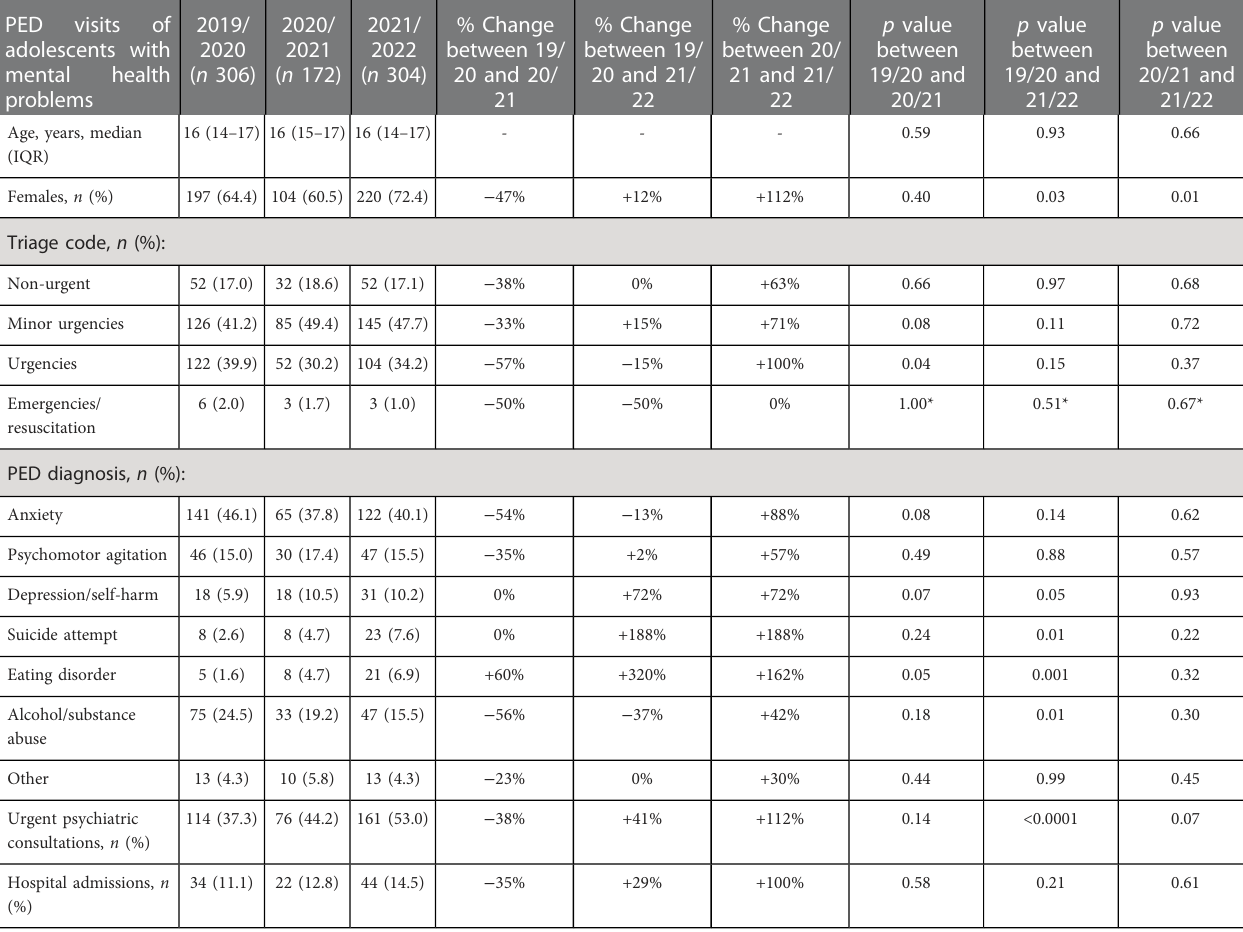
TABLE 2 Main features of the adolescents who accessed the PED with mental health problems during the study period. PED visits of adolescents with